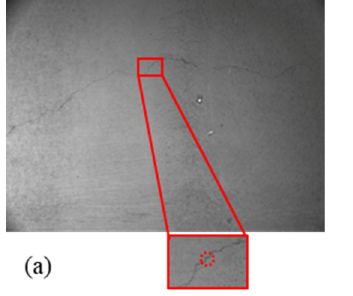
Figure 14. Crack width calculation picture, ( a ) the crack in No.1 linear interval, ( b ) the crack in No.2 linear interval, ( c ) the crack in the flat interval. Table 4. Crack width calculation comparison table.